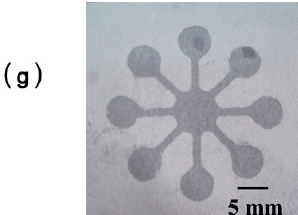
Figure 2. Scheme of the μ PAD fabrication in [59]: A filter paper mask ( b ) was obtained by cutting on a native filter paper ( a ), and was immersed in TMOS solution ( c ). The TMOS-adsorbed mask and a native filter paper were packed between two glass slides ( d ). TMOS molecules were assembled on the native filter paper by heating ( e ); and the fabricated μ PAD with hydrophilic-hydrophobic contrast ( f ) and its photograph ( g ) obtained by spraying water on it. With the permission from [59]; Copyright 2014, The Royal Society of Chemistry.